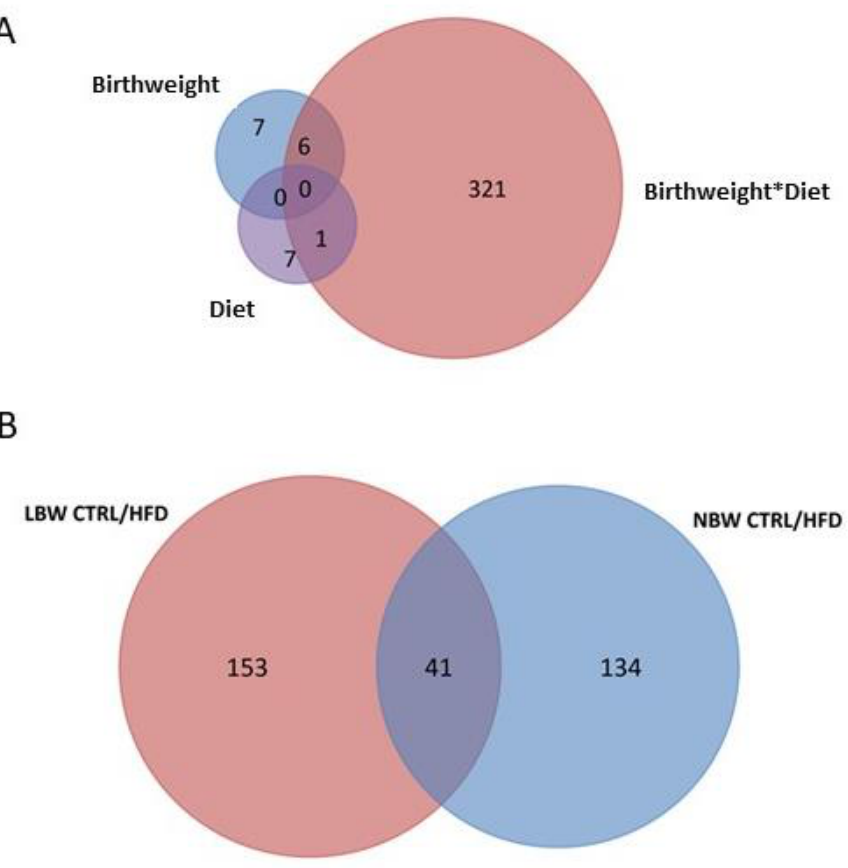
Figure 3. Venn diagram of differentially abundant proteins in the hippocampus of pigs. ( A ) Number of proteins identified by birth weight, diet and its interaction (Birthweight*Diet). ( B ) Number of proteins identified by comparing HFD vs. Ctrl in NBW and LBW groups.